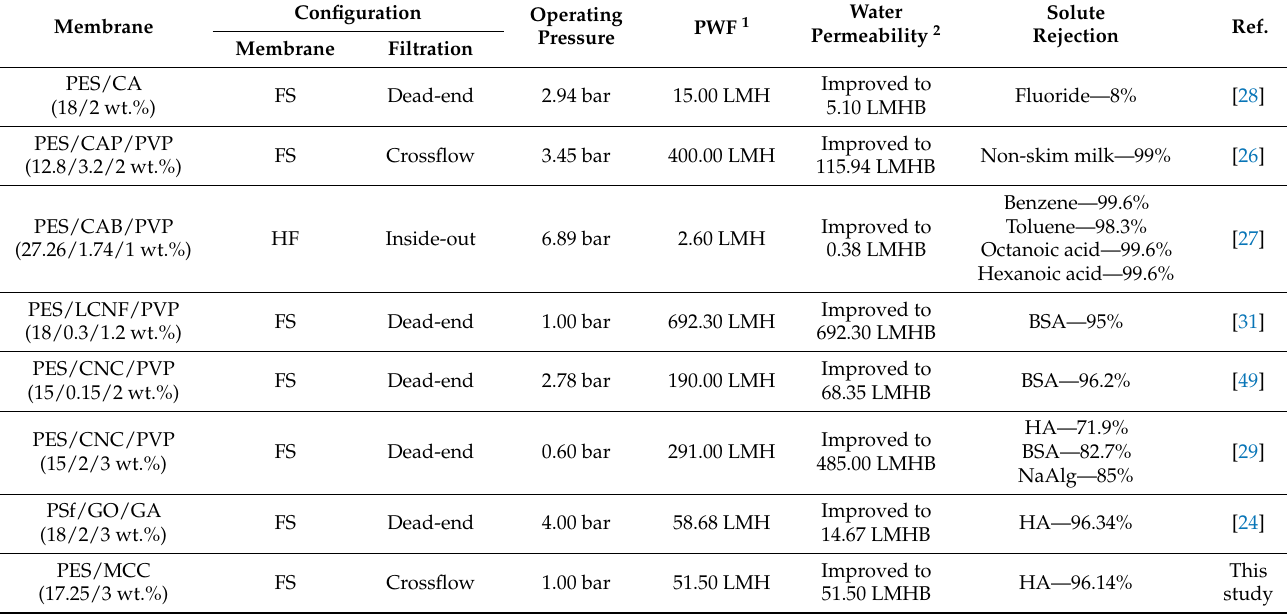
Table 3. Performance comparison between different optimized composite membranes reported in the literature and this